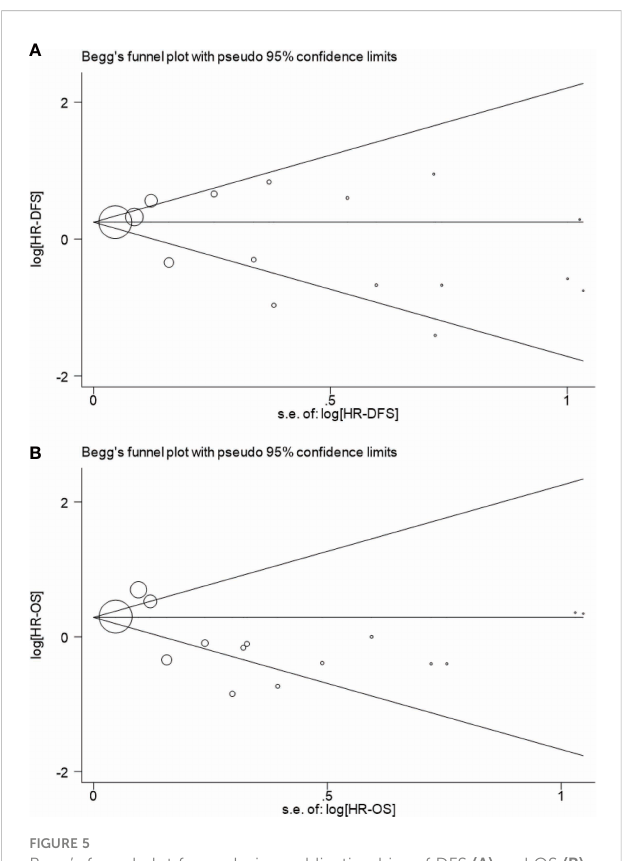
FIGURE 5 Begg ’ s funnel plot for analyzing publication bias of DFS (A) and OS (B) in patients with AML. A circle represents a study, and the diameter of circle represents sample capacity. DFS, disease-free survival; OS, overall survival; AML, acute myeloid leukemia. FIGURE 6